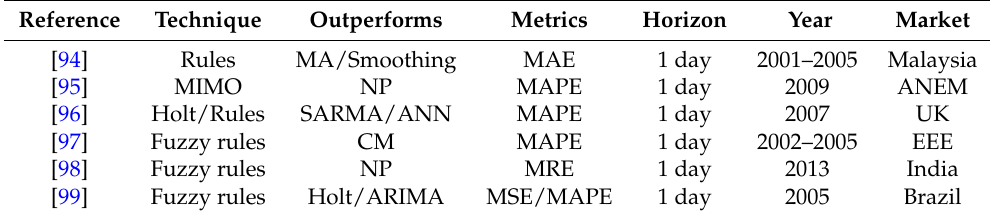
Table 6. Summary on rule-based methods for electricity